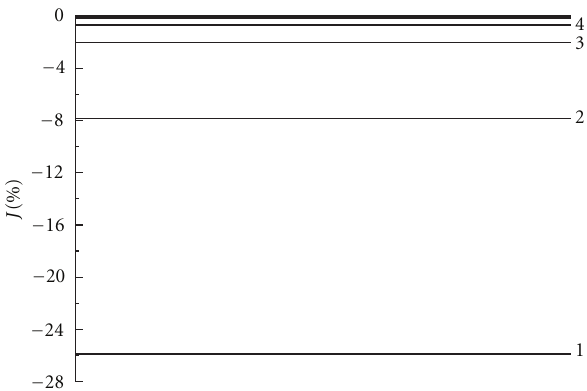
Figure 11: Binding energy of two solitons in stable steady states J expressed in relative units (the binding energy divided by the energy of a single soliton). The laser parameters are the same as in the case of Figure